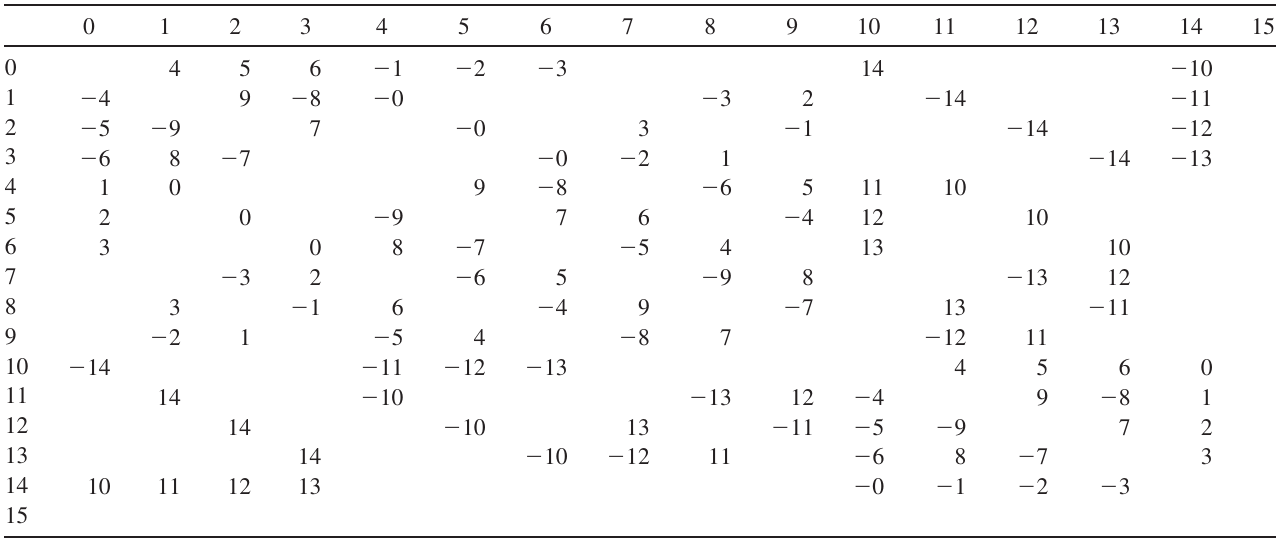
TABLE IV. Commutator table of the group of (cid:1) matrices: (cid:1) and c the table entry. The only matrix commuting with all other matrices is the unit matrix (cid:1)